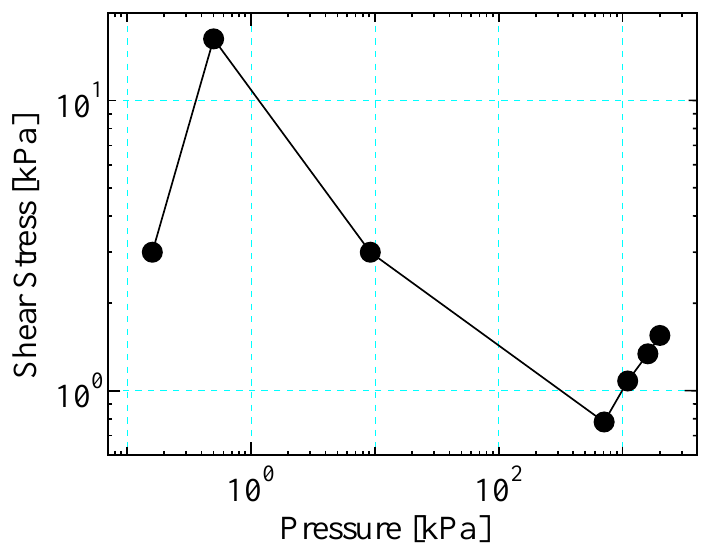
Figure 22. Shear stress vs. curvature.